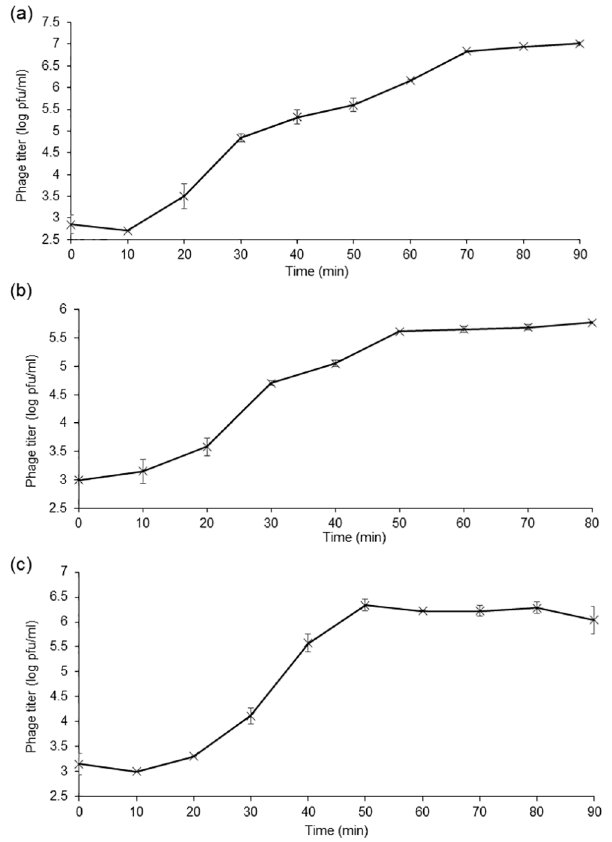
Fig 2. One-step growth curves of phages ɸ APCEc01 (a), ɸ APCEc02 (b), and ɸ APCEc03 (c) with E . coli strain DPC6051 in LB broth at 37°C.